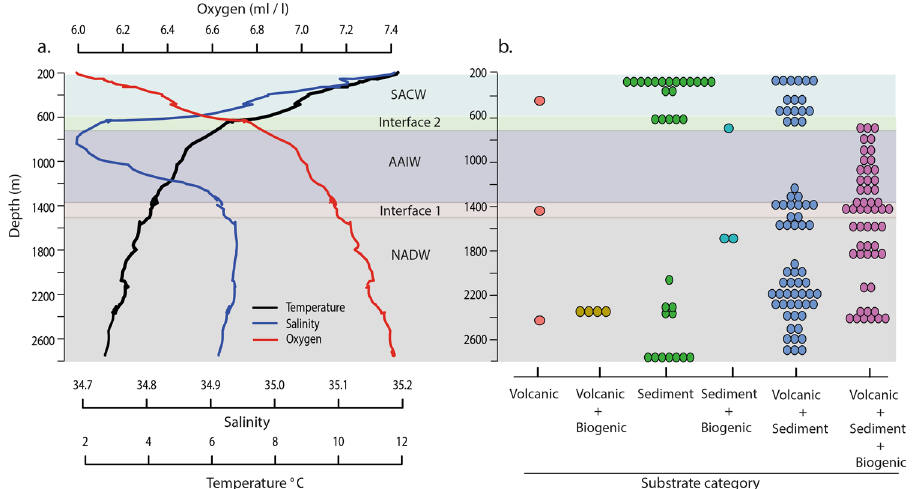
Figure 2. Temperature, salinity, oxygen and water mass categories from the ROV CTD ( a ) along with the different substrate categories across the seamount from the 100 m sample size ( b ). SACW = South-Atlantic Central Water, AAIW = Antarctic Intermediate Water, NADW = North- Atlantic Deep Water. The interfaces are defined from raw ROV CTD data (Supplementary Table